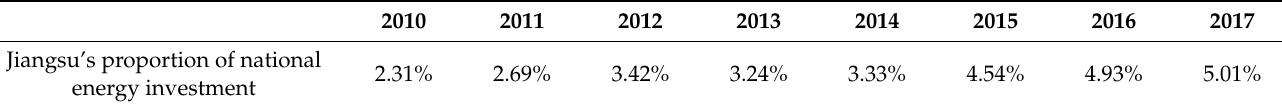
Table 1. Jiangsu’s share of national energy investment, Table 1. Jiangsu ’ s share of national energy investment, 2010 – 2017.